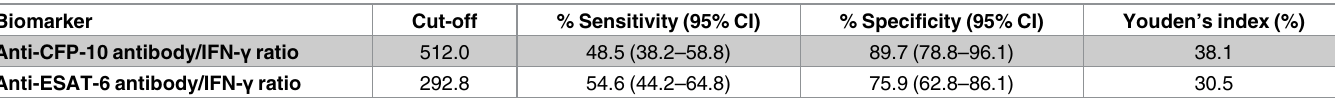
Table 3. Potential of anti-CFP-10 and anti-ESAT-6 antibody/IFN- γ ratios to differentiate active and latent TB infection.